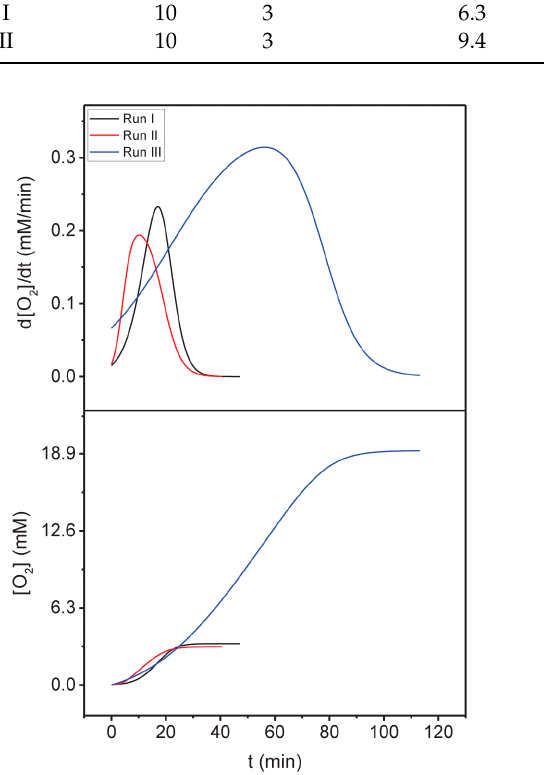
Figure 6. [O 2 ] ( bottom ) and d[O 2 ]/dt ( up ) versus time trends for a WO triple cerium ammonium nitrate (CAN) addition experiment (Table 1, entries 1–3).